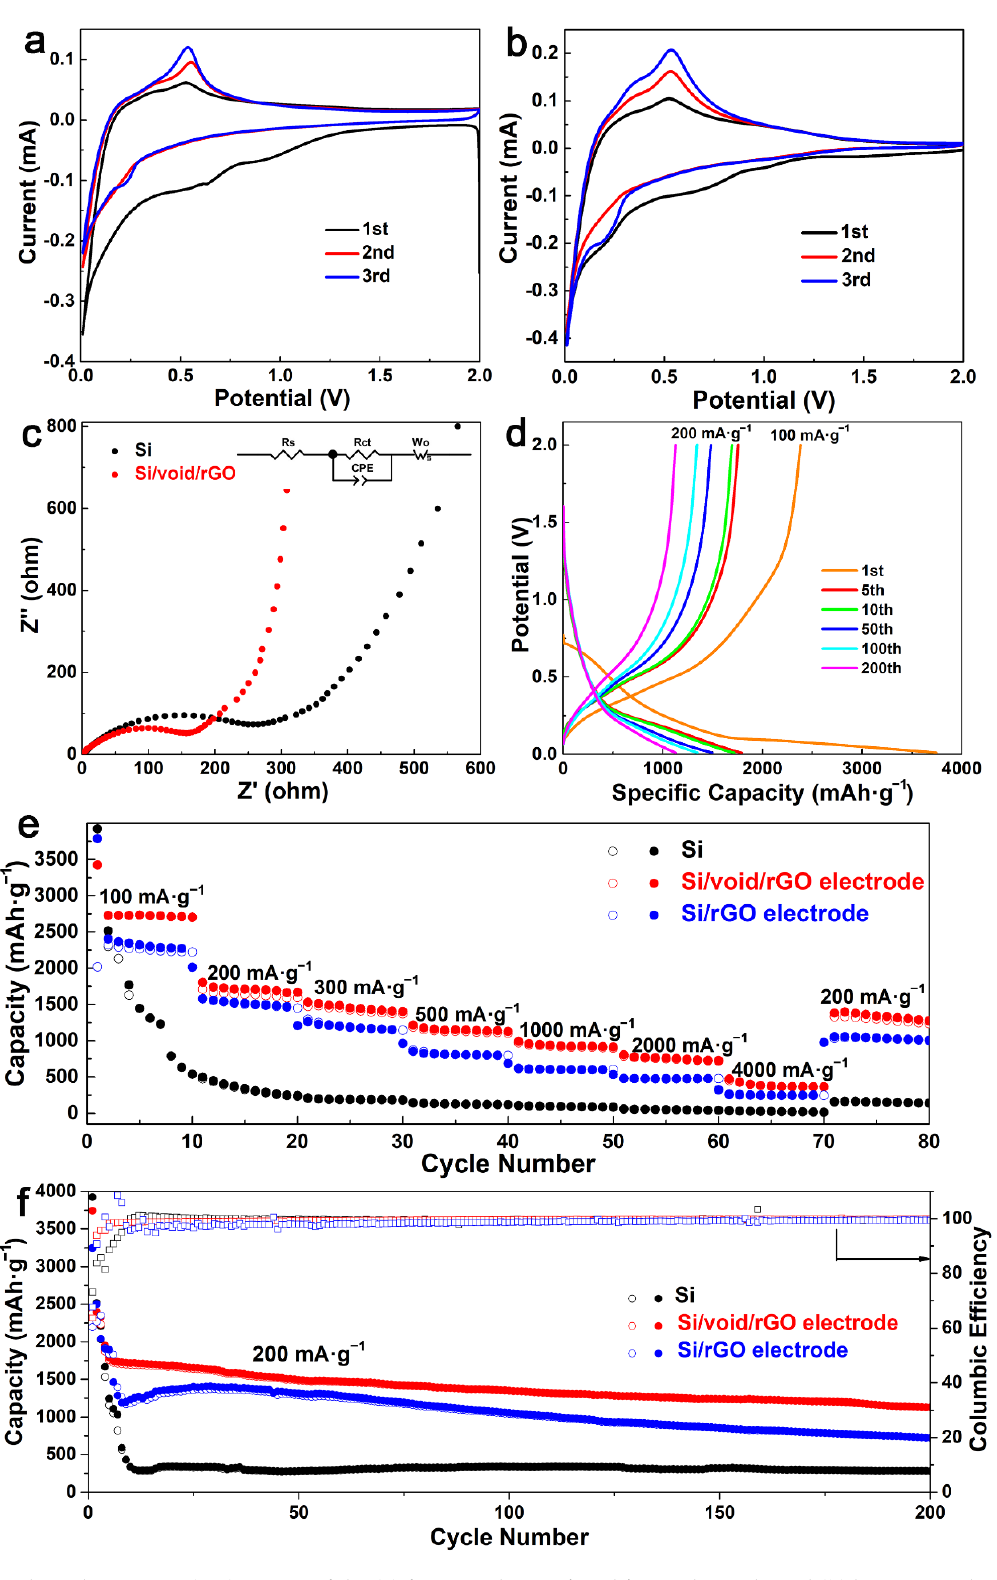
Figure 5. Cyclic voltammetry (CV) curves of the ( a ) free-standing Si/void/rGO electrode and ( b ) bare Si anode, ( c ) electro- chemical impedance spectroscopy (EIS) spectrum and fitted equivalent circuit diagram, ( d ) charge/discharge profiles of the free-standing Si/void/rGO electrode at 1st, 5th, 10th, 50th, 100th and 200th cycles, ( e ) rate performance at various current densities, and ( f ) cycling performance and coulombic efficiency (CE) at 200 mA·g −1 of the free-standing Si/void/rGO electrode, Si/rGO electrode and bare Si electrode.